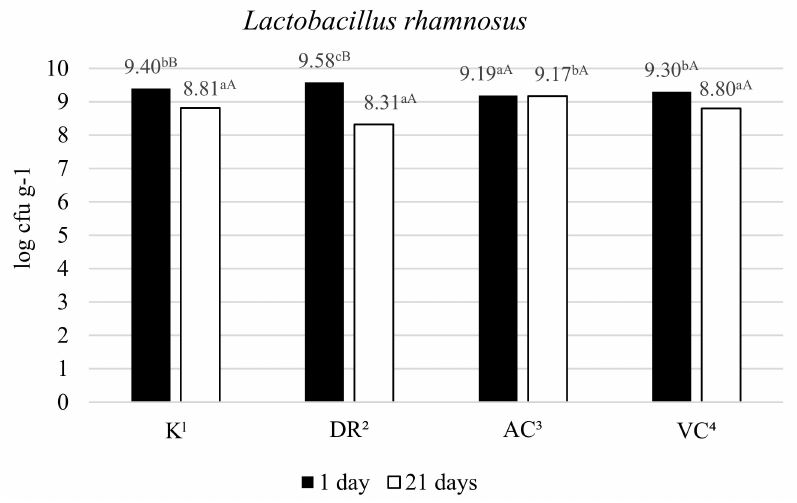
Figure 1. Viable counts in milk fermented by L. rhamnosus depending on the source of vitamin C [log cfu g − 1 ]; Values are means ± SD; n = 15 for each group; 1 —control milk; 2 —fermented milk with rosehip; 3 —fermented milk with acerola; 4 —fermented milk with L(+)ascorbic acid; A,B—mean values between 1 and 21 days of storage time denoted by different letters differ statistically signifi- cantly ( p < 0.05); a–c—mean values between the form of vitamin C denoted by different letters differ statistically significantly ( p <